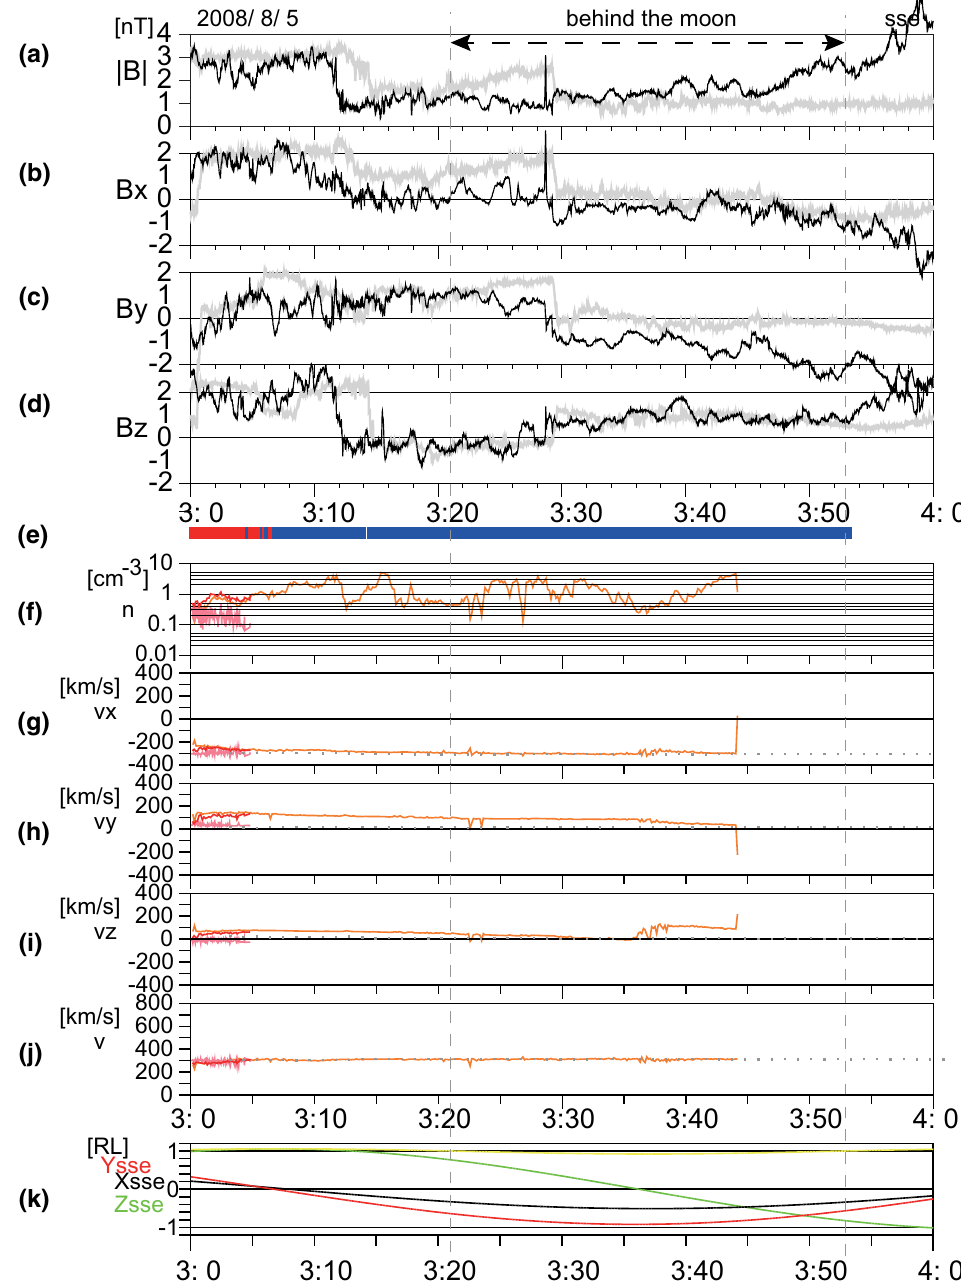
Fig. 6 Magnetic compression at a hot flow anomaly on August 5, 2008. a – d The magnetic field observed by Kaguya (black curves) in SSE coordinates and by ACE (gray curve) in the GSE coordinate system shifted by a travel time of 1.04 h from ACE to Kaguya. e Magnetic connection between Kaguya and the dayside (red) or nightside (blue) surface of the moon. f Ion density and g – j bulk velocity observed by MAP/PCE. Pink, orange and red curves are measurements from IEA, IMA sensors and their combination. Gray dots are upstream solar wind parameters observed by ACE. k The position of Kaguya in SSE coordinates. The yellow line shows (cid:31) y 2 SSE + z 2 SSE normalized by the lunar radius. Vertical dashed lines mark Kaguya crossings of the boundary of the shadow of the